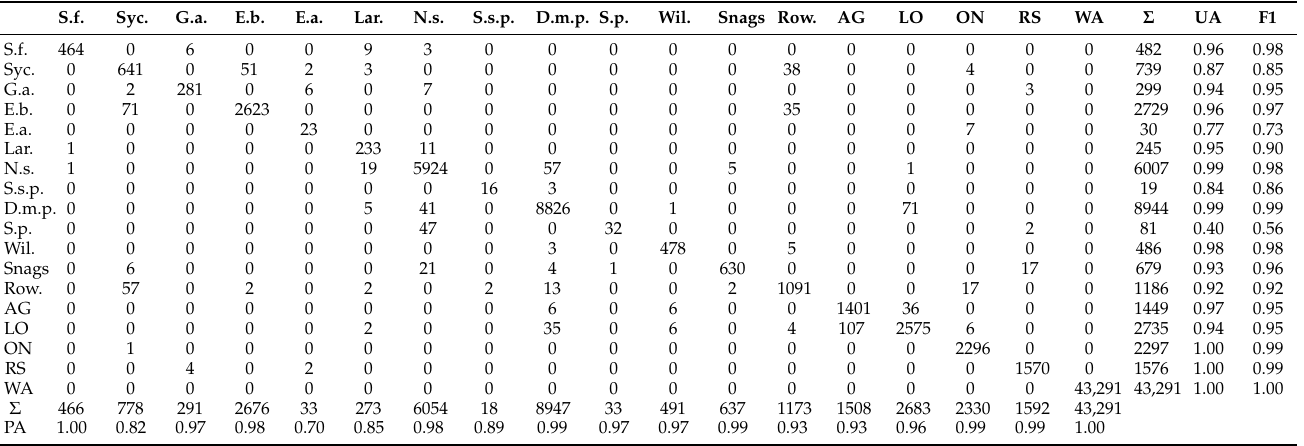
Table A3. Error matrix of obtained PlanetScope, with topographic features and Support Vector Machine classification results. S.f.—silver fir ( Abies alba ); Syc.—sycamore ( Acer pseudoplatanus ); G.a.—grey alder ( Alnus incana ); E.b.—European beech ( Fagus sylvatica ); E.a.—European ash ( Frax- inus excelsior ); Lar.—larch ( Larix spp.); N.s.—Norway spruce ( Picea abies ); S.s.p.—Swiss stone pine ( Pinus cembra ); D.m.p.—dwarf mountain pine ( Pinus mugo ); S.p.—Scots pine ( Pinus sylvestris ); Wil.—willow ( Salix spp.); Row.—rowan ( Sorbus spp.); AG—alpine grasslands; LO—low shrubs; ON—other nonforest; RS—rocks and artificial surfaces; WA—water; UA—user accuracy; F1—F1- score; PA—producer accuracy.